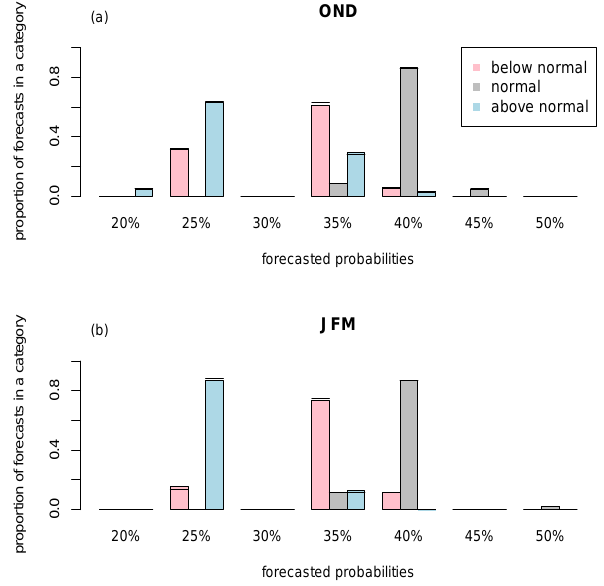
Figure 2. The distribution of forecasted probabilities of early (OND) and late (JFM) season forecasts. Proportions of different forecast probabilities for each category are shown, so bars of the same color add to one. Bars are calculated using the 1 . 0 ◦ × 1 . 0 ◦ grid, results using the 2 . 5 ◦ × 2 . 5 ◦ grid are shown as vertical lines over the